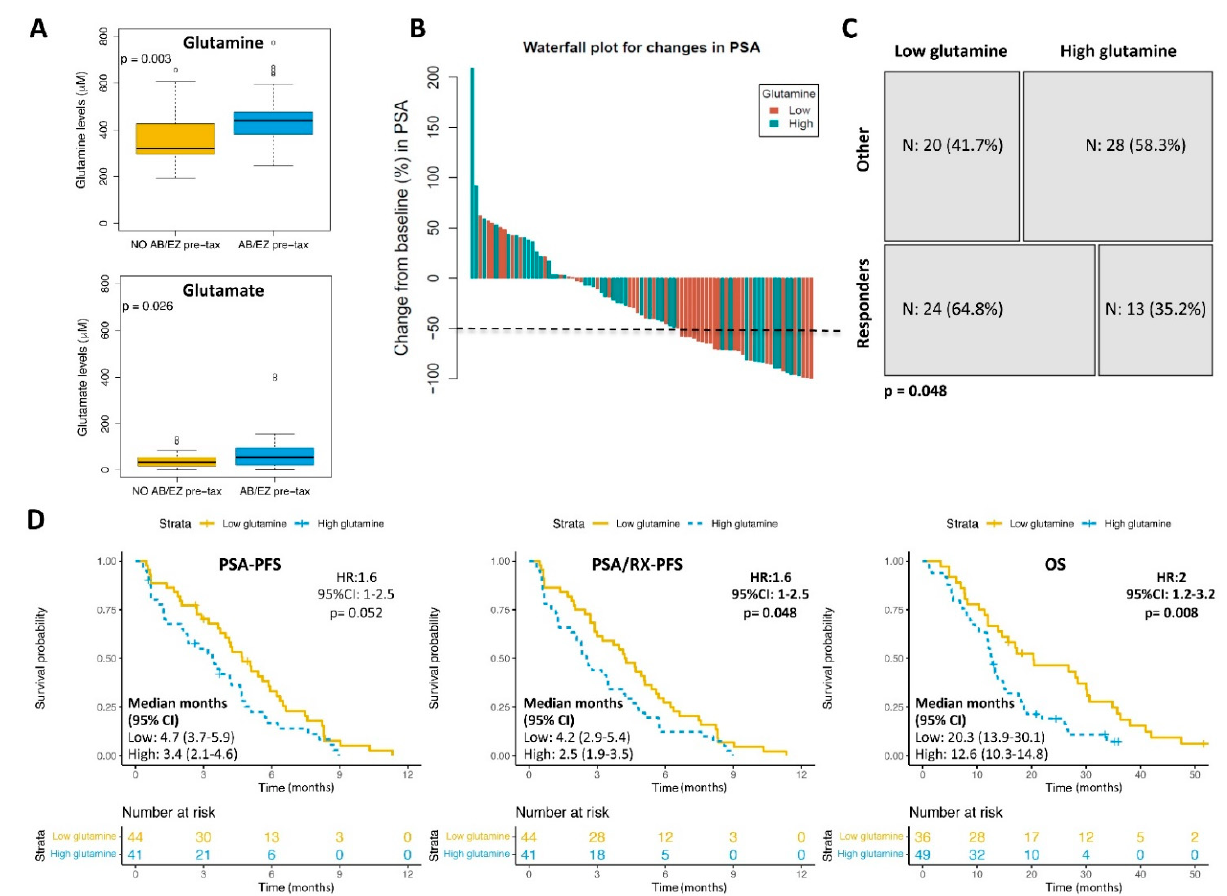
Figure 2. Plasma levels of glutamine and glutamate and the clinical outcome. ( A ) Boxplot of the glutamine (up) and glutamate (down) levels in patients according to the administration of hormone therapy with abiraterone (AB) or enzalutamide (EZ) before taxanes. t -test ( p -value). ( B ) Waterfall plot showing the % of change in the prostatic-specific antigen (PSA) levels after taxanes treatment according to the plasma glutamine levels (high or low). The dotted line represents the limit to consider the biochemical response. ( C ) Contingency table showing the number ( N ) and % of patients responding to the taxanes vs. non-responders or the stable disease (other), according to the glutamine levels. Fisher’s Exact Test ( p -value). ( D ) Kaplan–Meier curve representing PSA-PFS, PSA/RX-PFS and OS according to the glutamine plasma levels. CI: confidence interval; HR: hazard ratio; Wald test ( p -value); Time in months. Table 2. Univariate and multivariate Cox model for PSA-PFS, PSA/RX-PFS and OS in patients from the plasma samples cohort adjusted for clinically significant variables ( p < 0.1) in the univariate analysis.